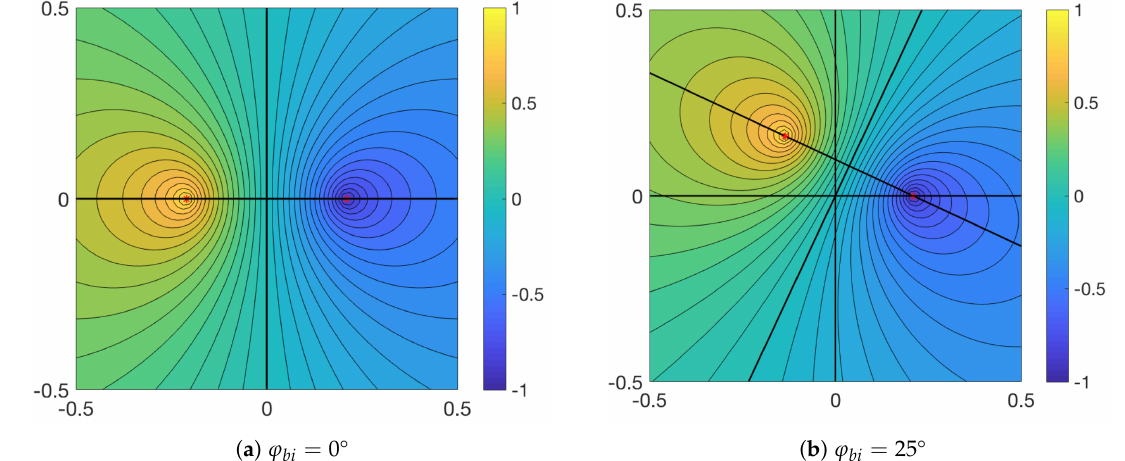
Figure 8. The frequency contours of Equation (36) shown for m (cid:54) = m (cid:48) (where m = 1) with two different values for ϕ bi : (a) monostatic ϕ bi = 0 and (b) bistatic angle ϕ bi = 25°. The colour shows the value of the normalised frequency, η = ω / ω B , in the p , q